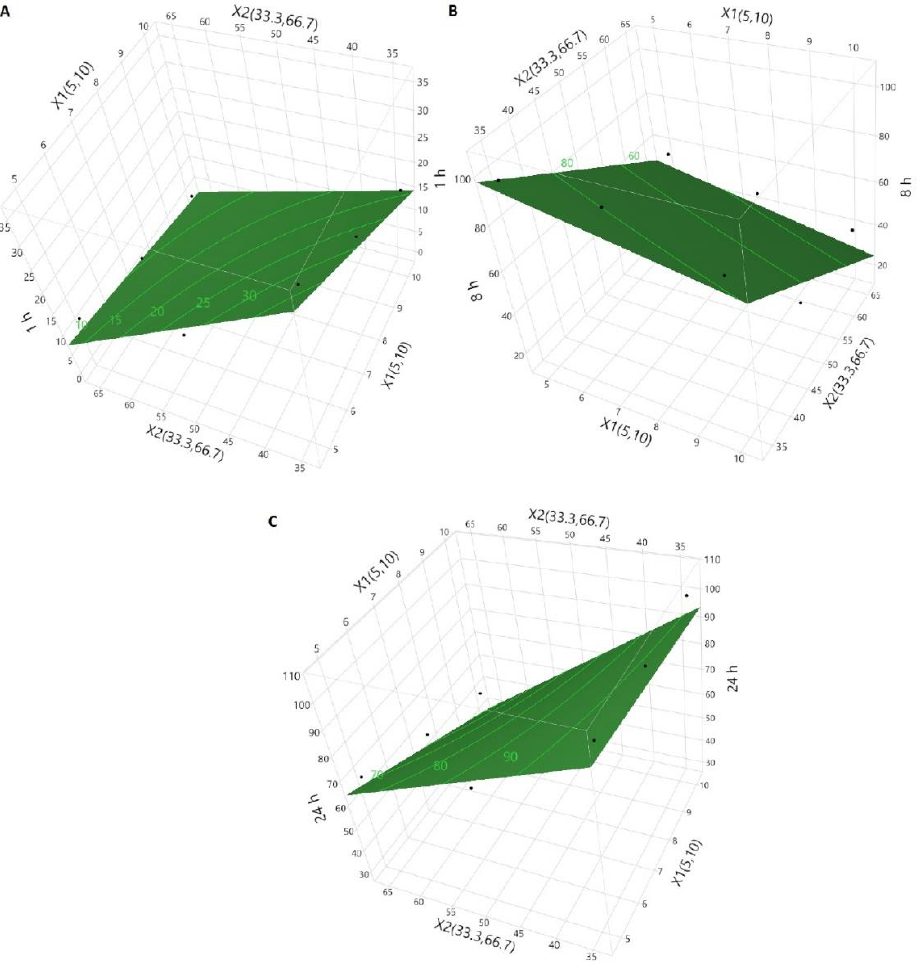
Figure 5. Response surface curves of ( A ) Y 1 , ( B ) Y 2 , and ( C ) Y 3 tablets coated with CAB 171-15/C-A-P blend.